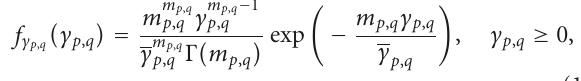
is proposed. A distributed double-di ff erential modulation based on [12] with regenerative relays over cooperative Rayleigh channels is proposed and an upper bound of the pairwise error performance (PEP) is obtained in [13]. It is assumed in [13] that the flat-fading part of the time- varying channel remains constant over 10 4 time intervals [13, Sections IV and